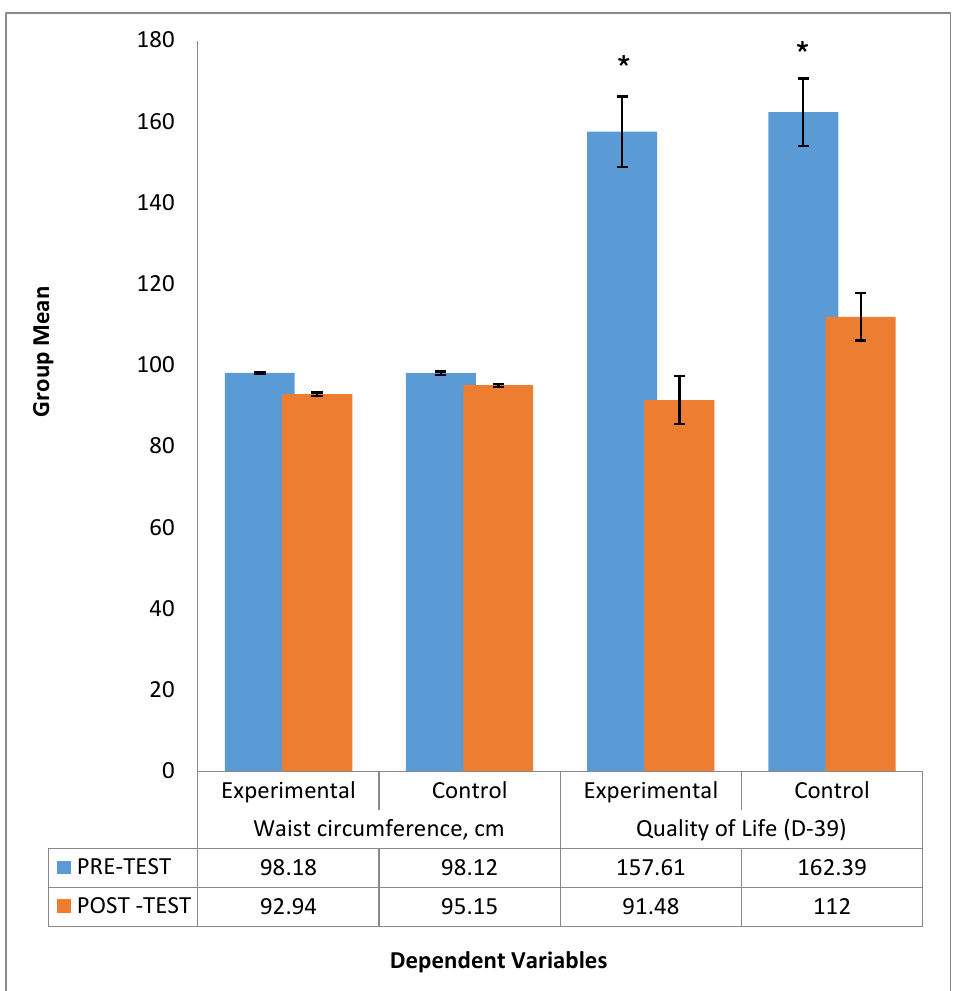
Figure 3. Comparison between the group mean of Waist circumference and Quality of life before andafter intervention. * signify statistical significant di ff erent between pre-test and post test mean scores of experimental and control groups.